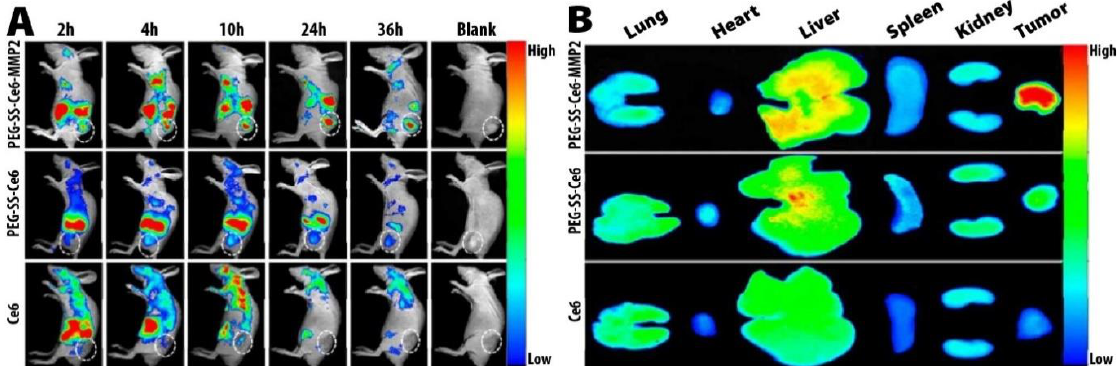
Figure 10. In vivo biodistribution and tumor accumulation of PEG-SS-Ce6-MMP2 NP compared with free Ce6 and PEG-SS-Ce6 NPs. ( A ) In vivo whole-body fluorescence imaging after intravenous injection of free Ce6, PEG-SS-Ce6, and PEG-SS-Ce6-MMP2 NPs to A549 tumor-bearing mice in a time dependent manner. ( B ) In vitro fluorescence images of drug accumulation in major organs and tumors of mice, 36 h after the intravenous injection of free Ce6, PEG-SS-Ce6 NPs, or PEG-SS-Ce6-MMP2 NPs. Adapted with permission from Ref. [132]. Copyright 2021 American Chemical